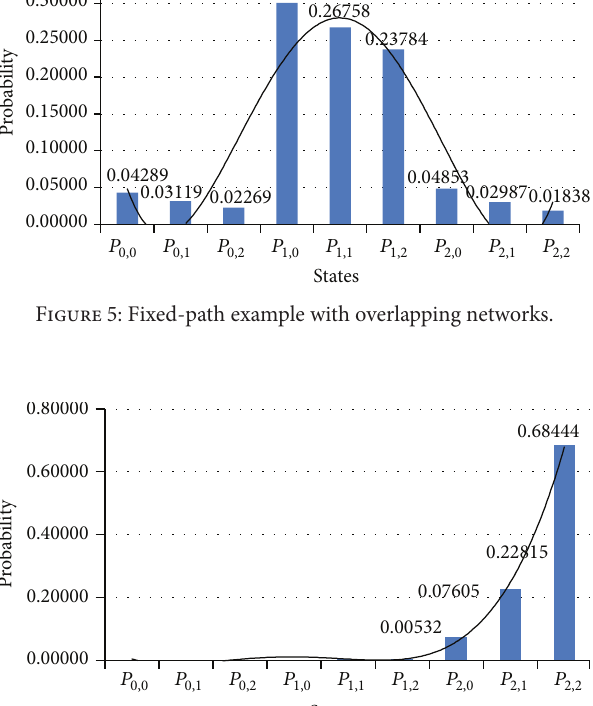
Table 1: Fixed-path mobility with overlapping networks.